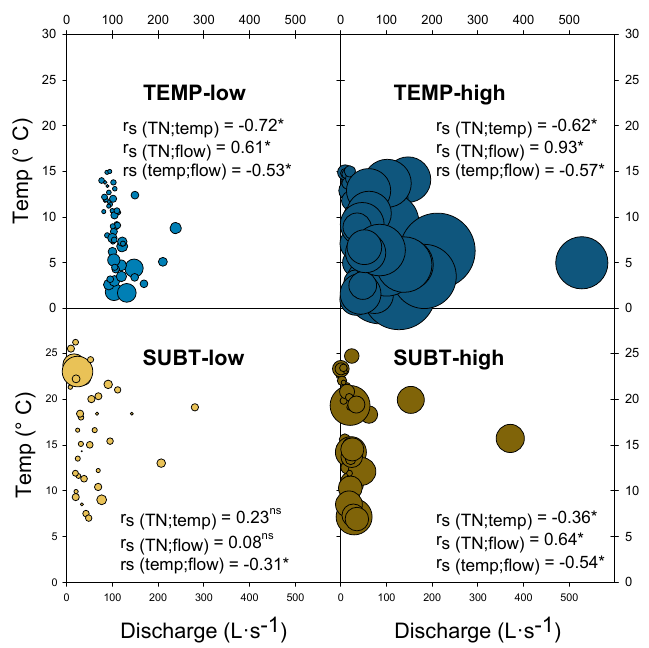
Figure 3. Total nitrogen concentrations vs. water temperature and discharge in the subset of the four benchmark streams under high-frequency monitoring. Bubble size represents the concentration of TN from fortnightly grab sampling (two-year data). The graphs show the main environmental gradients for each stream. Spearman rank-order correlations (rs) are marked with * when significant (0.01 ≤ p ≤ 0.05). ns: non-significant. Abbreviations: TEMP: temperate streams; SUBT: subtropical streams; low and high: low and high-farming intensity in the catchments.